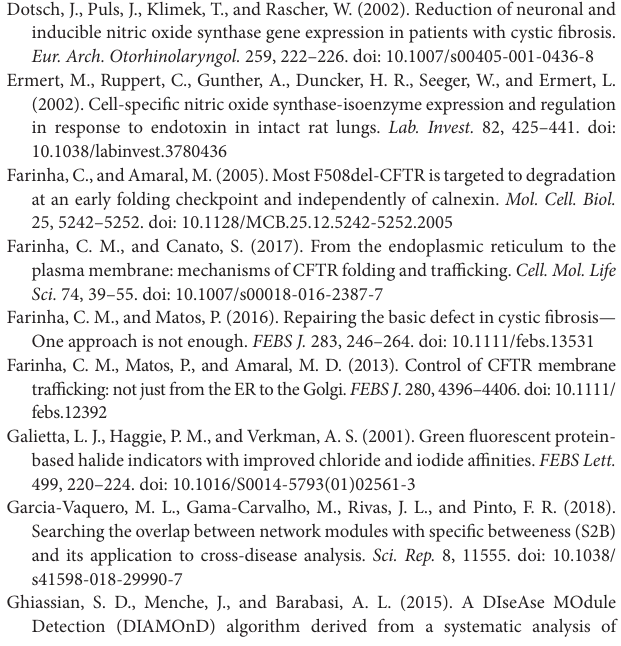
TABLE S1 | Specific common neighbours of CFTR interactor sets. TABLE S2 | Enriched biological processes in the list of strong mediator